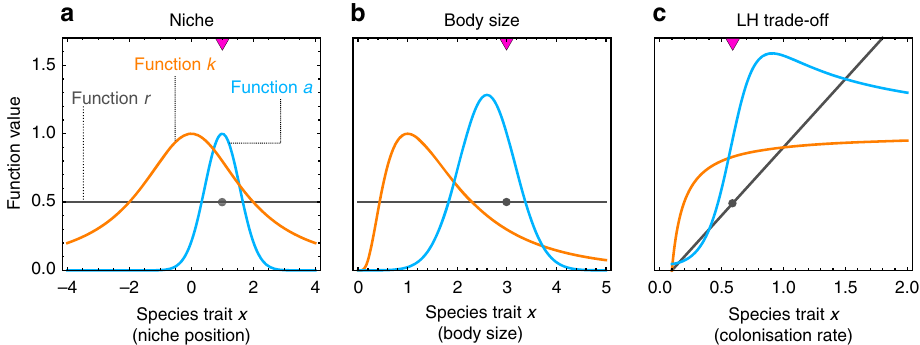
Figure 1 | Specific functions corresponding to the three ecological scenarios. Functions r , k and a are shown for the niche ( a ), body-size ( b ), and life-history (LH) trade-off ( c ) scenarios. For simplicity we depicted a situation with one resident species (with trait value x i ; purple triangles and dots). Functions r and k are the intrinsic growth-rate and carrying capacity of a species, respectively, as a function of its trait value. Note that there is an intermediate k optimum in the niche and body-size scenarios, but not in the LH-trade-off scenario. For function a we represented a ( x i , x j ), that is, the impact that the resident species has on other species depending on their trait values. Note that a is symmetric and less than one in the niche scenario, but asymmetric and possibly greater than one in the body-size and LH-trade-off